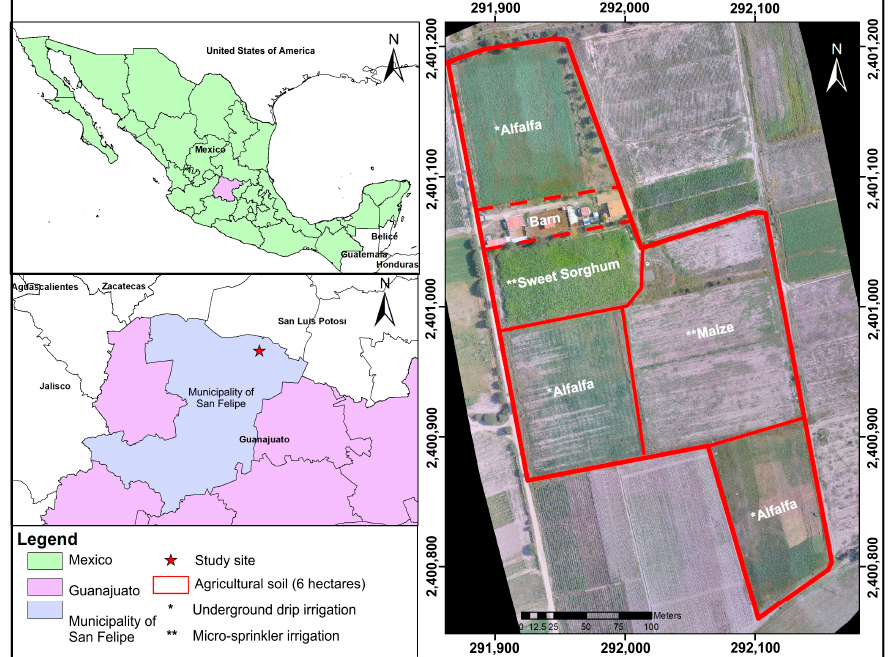
Figure 1. Study area of 6 ha split into five agricultural plots. A small area not used to crop is separated by dashed red lines.